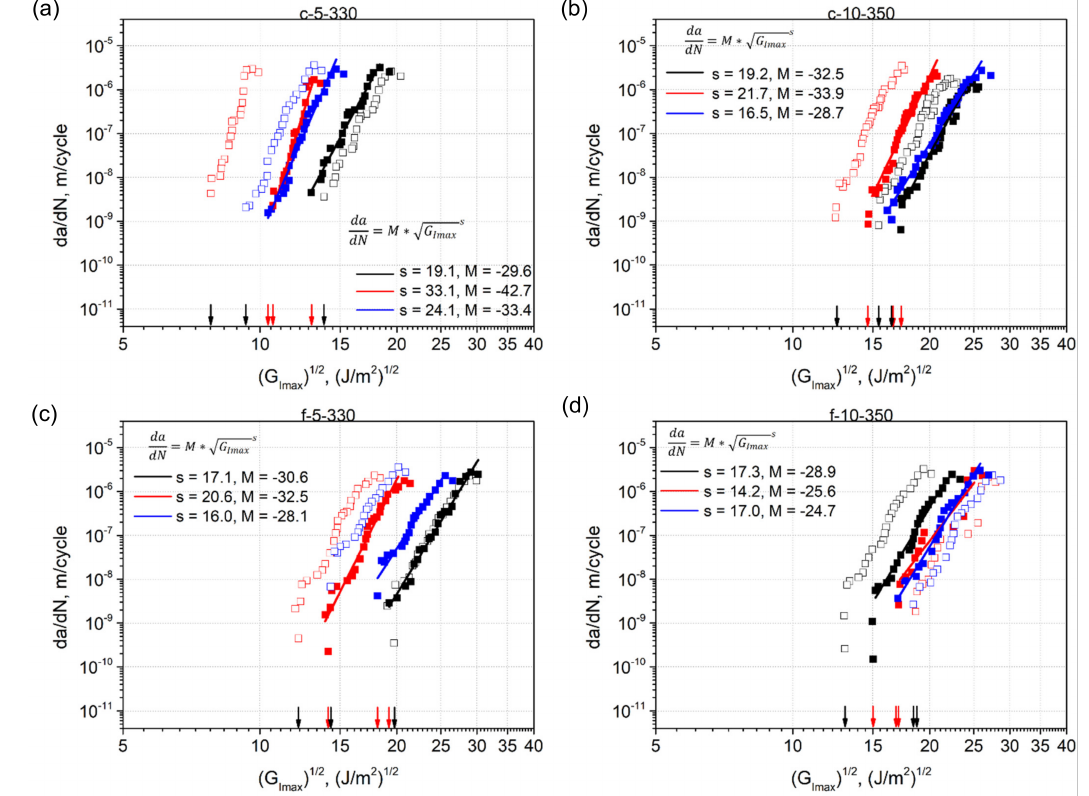
√ G Imax calculated using CBT with a calc (Equation (3)) and ECLM with Figure 10. Paris-type plots of da / dN plotted versus a ef f (Equation (4)) for: ( a ) c-5-330; ( b ) c-10-350; ( c ) f-5-330; and ( d ) f-10-350. The black and red arrows along the X-axis refer (cid:112) G Imax _ th of the data calculated using a calc and a ef f , respectively. Black, red, and blue lines refer to linear regressions to fitted to the effective